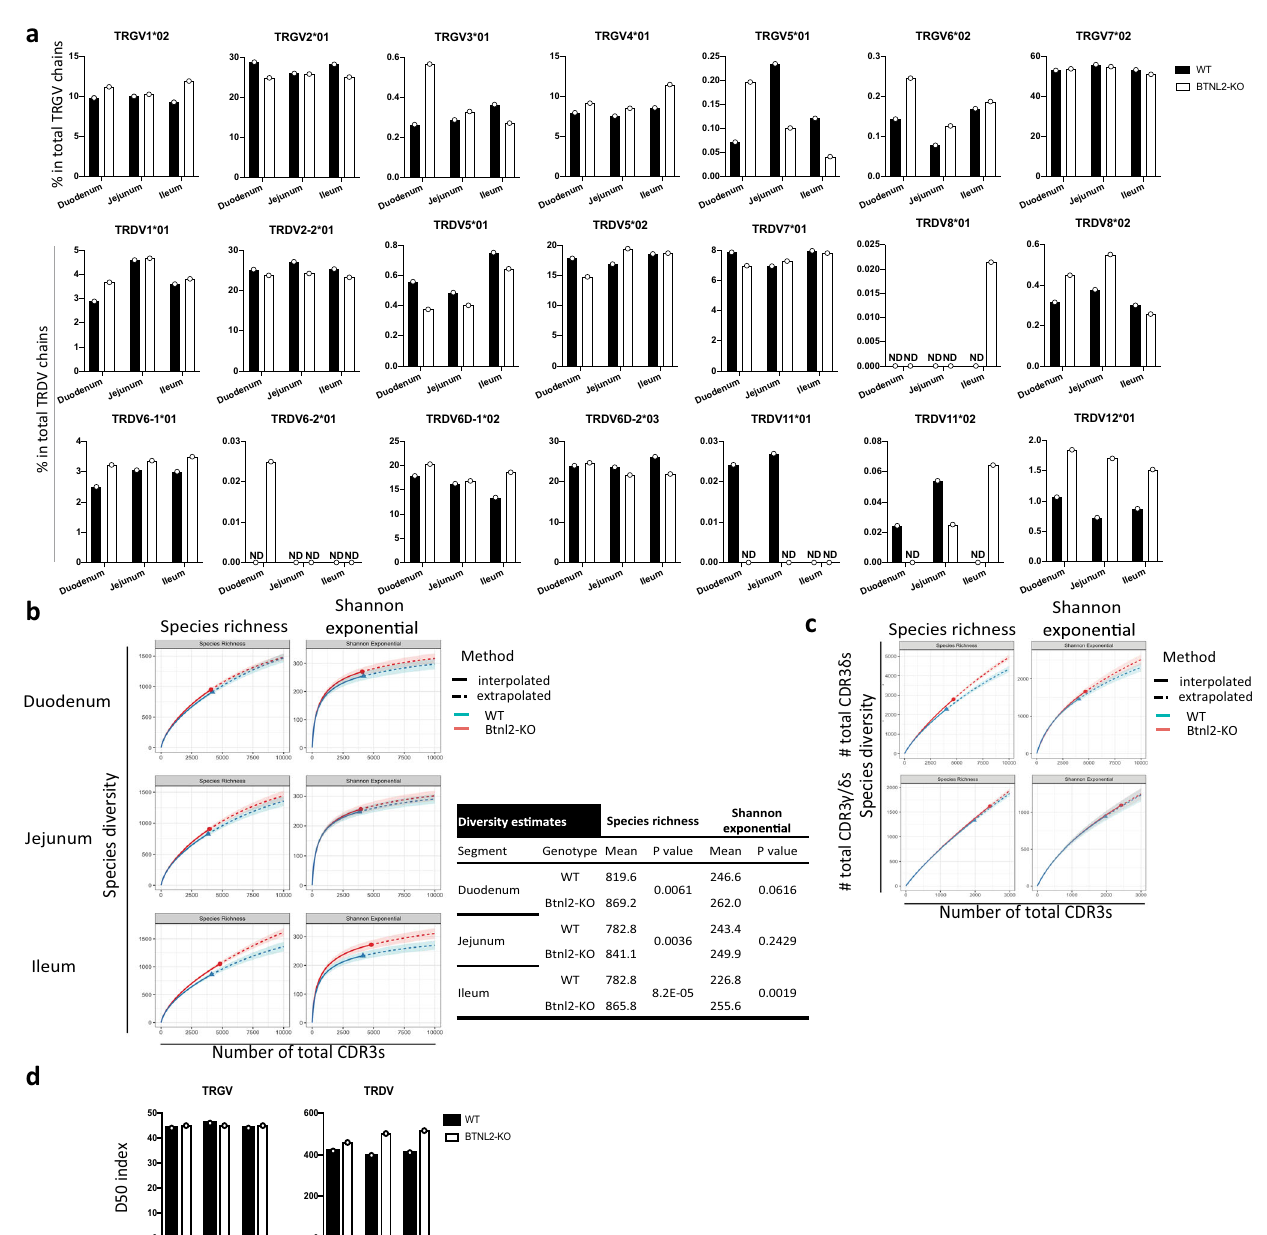
Fig. 5 Ileal Btnl2-KO γδ IELs exhibit more diverse TRGV repertoire compared to ileal WT γδ IELs. γδ IELs from the duodenum, jejunum, and the ileum of cohoused 11-week-old Btnl2-KO and WT littermates ( n = 3 – 4/genotype, a pool of 2 mice, each) were sort-puri fi ed as CD45 + TCR β -TCR γδ + cells. Two- thirds of each sample were processed for deep bulk RNA sequencing and one-third of each sample was pooled per genotype per segment and used for single-cell sorting and single-cell TCR sequencing. γδ IELs from duodenum, jejunum, and ileum of cohoused 11-week-old Btnl2-KO and WT littermates ( n = 8 mice, each) were single-cell sorted and single-cell TCR sequencing analysis of TCR V γ and TCR V δ chain usage and CDR3 aminoacid sequences was performed. a TRGV*J and TRDV*J gene usage in Btnl2-KO and WT γδ IELs. ND not detected. b Top-Diversity estimates for TRG only CDR3 aminoacid sequences in Btnl2-KO and WT γδ IELs. Shaded areas indicate the 95% con fi dence interval by 50 bootstrap replicates. Bottom-TRG diversity estimates at interpolation point 3500, where p value is derived from t-test based on 50 bootstrap replicates. c Diversity estimates for TRD only and paired TRG and TRD CDR3 aminoacid sequences, respectively, in ileal Btnl2-KO and WT γδ IELs. Shaded areas indicate the 95% con fi dence interval by 50 bootstrap replicates. d Diversity 50 (D50) index represented as the number of top unique clones that comprise 50% of the TRGV and TRDV repertoires, respectively, normalized to the total number of unique clones of duodenal, jejunal and ileal Btnl2-KO and WT γδ IELs. KO γδ IELs also showed a trend towards higher diversity in TCR sampled 3500 γ chains from each sample by 50 bootstrap γ chain compared to WT γδ IELs but the difference was marginal replications and observed that the mean Shannon diversity of ileal when contrasted to their ileal counterparts ( p = 0.0616 and Btnl2 -KO γ chains was 255.6, signi fi cantly higher than 226.8 in 0.2429, respectively for Shannon diversity when sampling 3500 γ WT ( p = 0.0019, T -test) (Fig. 5b). Duodenal and jejunal Btnl2 -